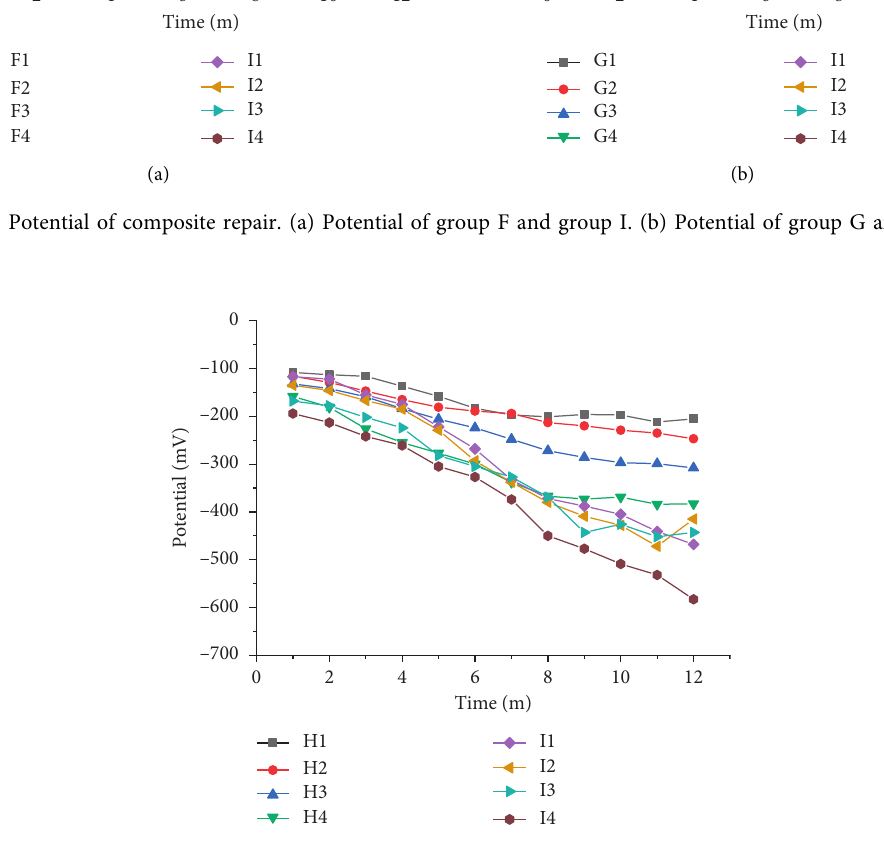
Figure 10: Potential of composite